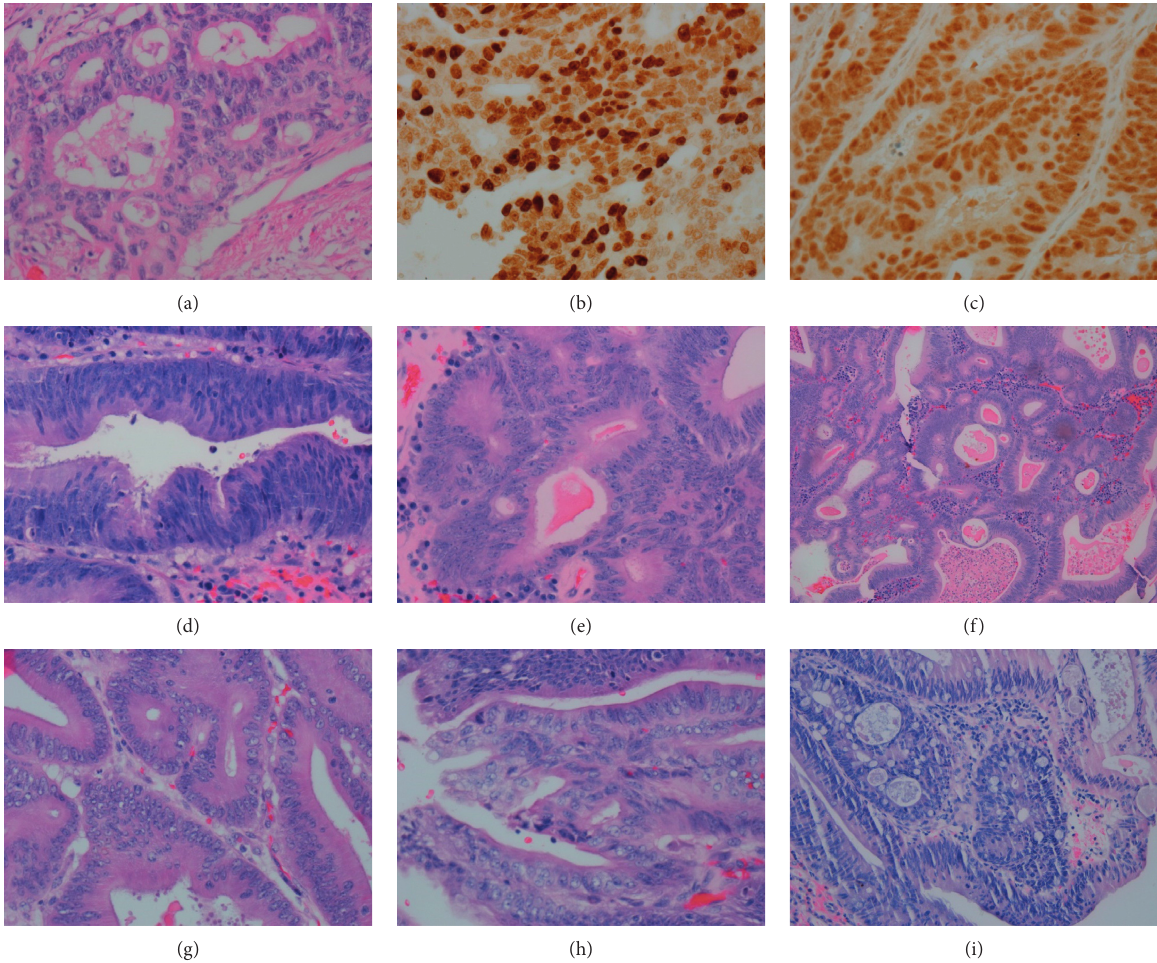
Figure 2: Pathology image. III1, postoperative pathology of colon cancer showed raised tubular adenocarcinoma grade II. (a) H&E staining, × 400, Ki67 (60%+, × 400), (b) P53 (wild type, × 400), (c) II8, common bile duct adenoma with high-grade intraepithelial neoplasia (d) × 400, (e) × 400, and (f) × 100, papillary tubular adenoma of duodenal papilla with local high-grade intraepithelial neoplasia (g), (h) × 400, and colon tubular adenoma-like polyp (i) ×